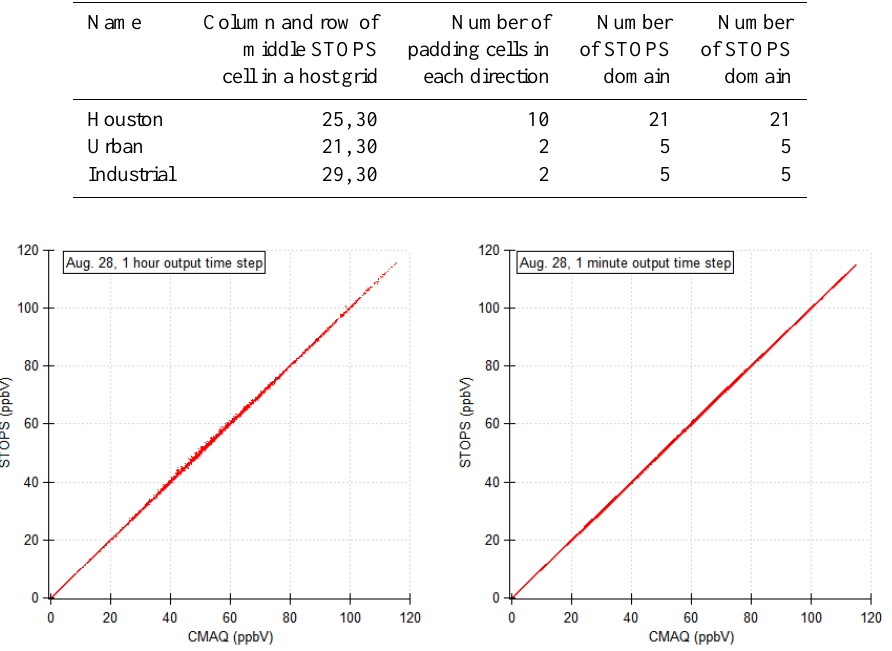
Figure 3. Comparison of CMAQ and static STOPS simulation results for 28 August for 1h (left) and 1min (right) output time steps. Both graphs correspond to the simulation from the Houston